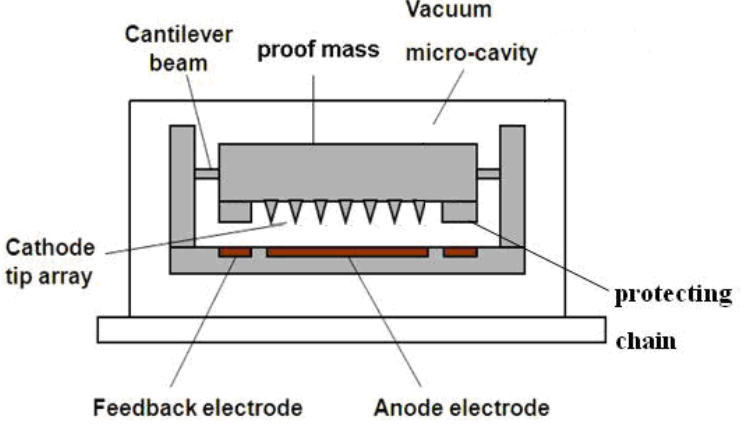
Figure 1. Structure diagram of vacuum microelectronic accelerometer.